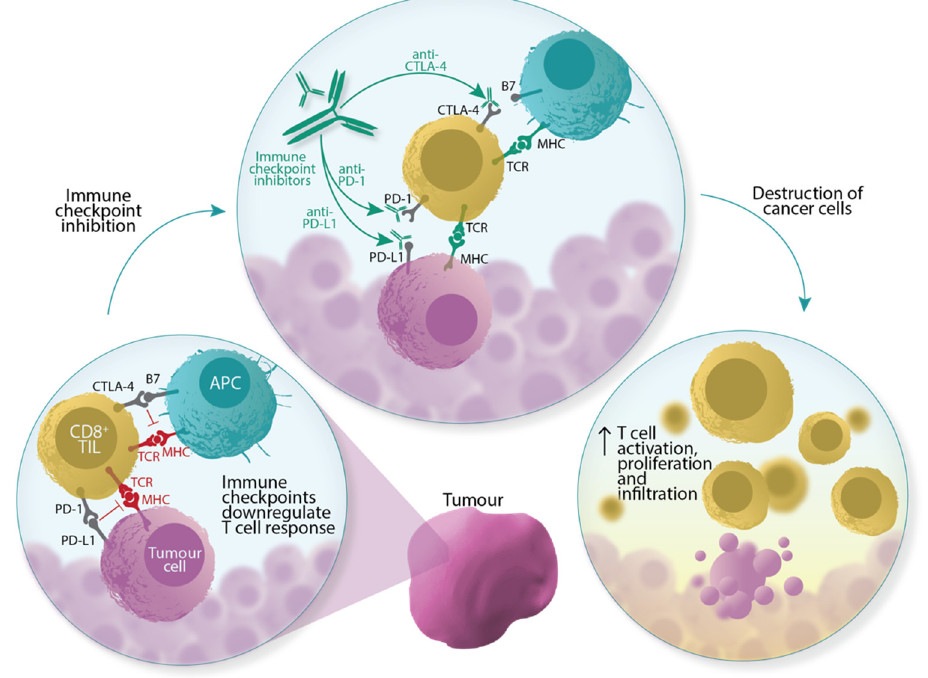
Figure 1. Immune checkpoint inhibitors induce tumour cell death by activating pre-existing CD8 + TILs. CD8 + TILs express T cell receptors (TCRs) that recognise antigens presented by major histocompatibility complexes (MHCs) on either tumour cells or antigen-presenting cells (APCs). TCR–antigen–MHC interactions prime and activate CD8 + TILs to induce apoptosis. This interaction, however, is downregulated by the activation of immune checkpoints, for example, the binding of cell surface receptor proteins PD-L1 (programmed death-ligand 1) with PD-1 (programmed death-1), and CTLA-4 (cytotoxic T lymphocyte-associated antigen-4) with B7 proteins. The blockade of these axes, via ICIs, allows CD8 + TILs to circumvent these inhibitory signals.